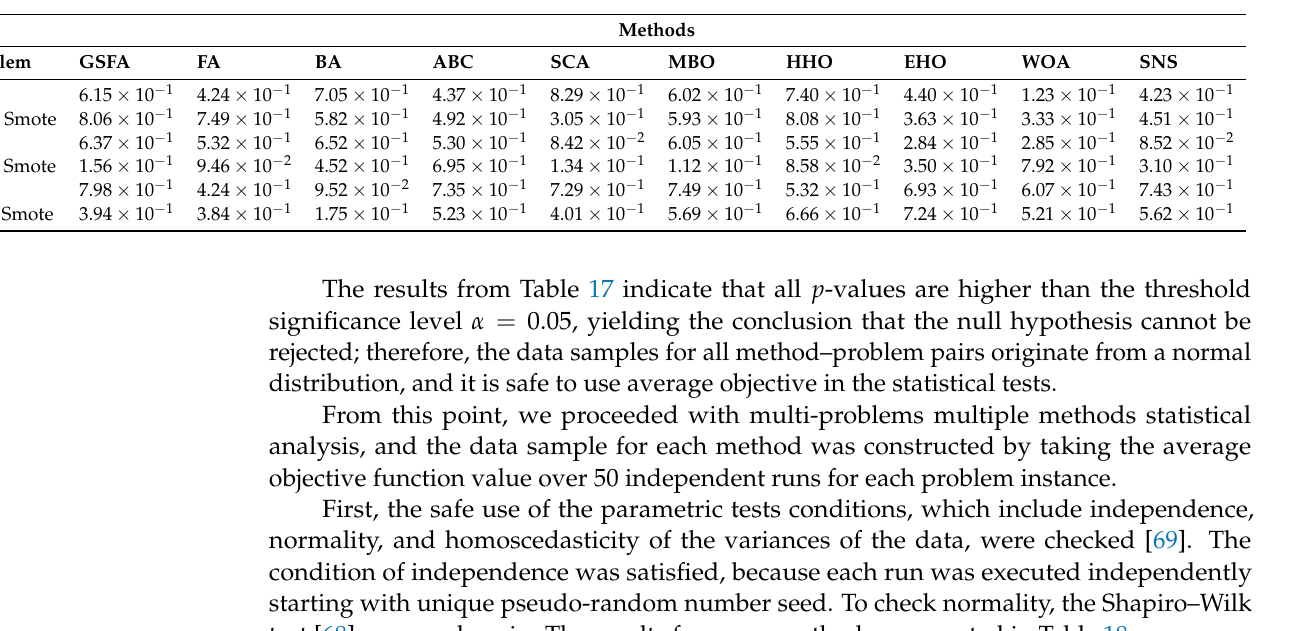
Table 17. Shapiro–Wilk test results for single-problem analysis.